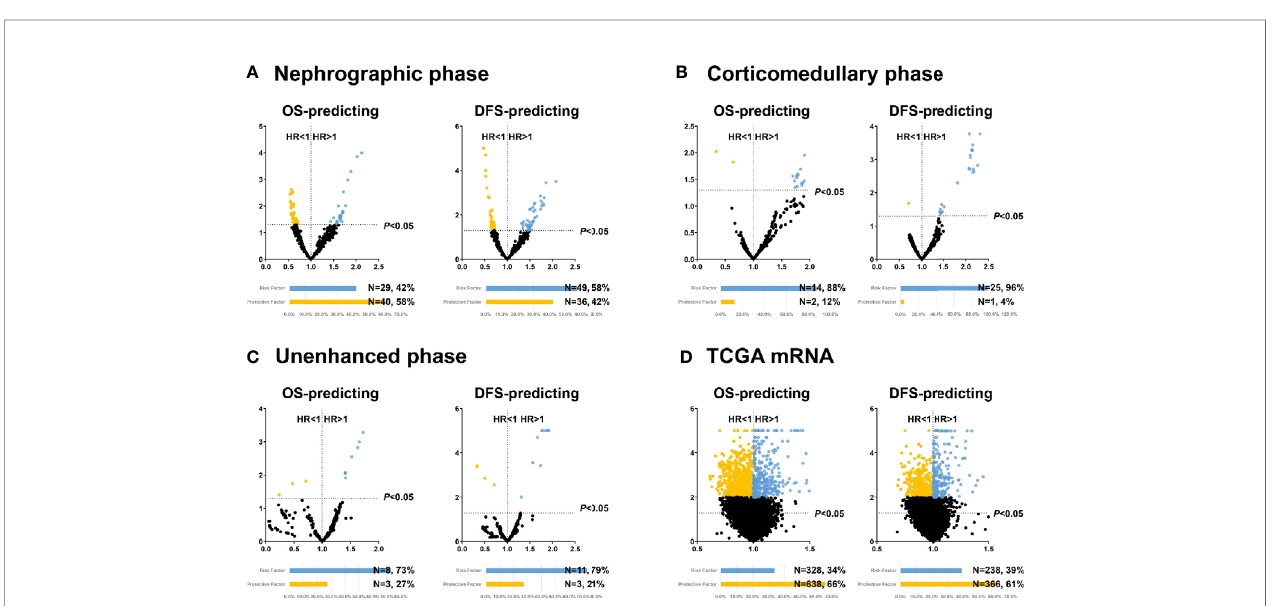
FIGURE 3 | Volcano plots illustrating the univariate COX regression results of features extracted from nephrographic (A) , corticomedullary (B) and unenhanced (C) phase and transcriptome mRNA level (D) . OS, Overall survival; DFS, Disease-free survival; HR, Hazard ratio.